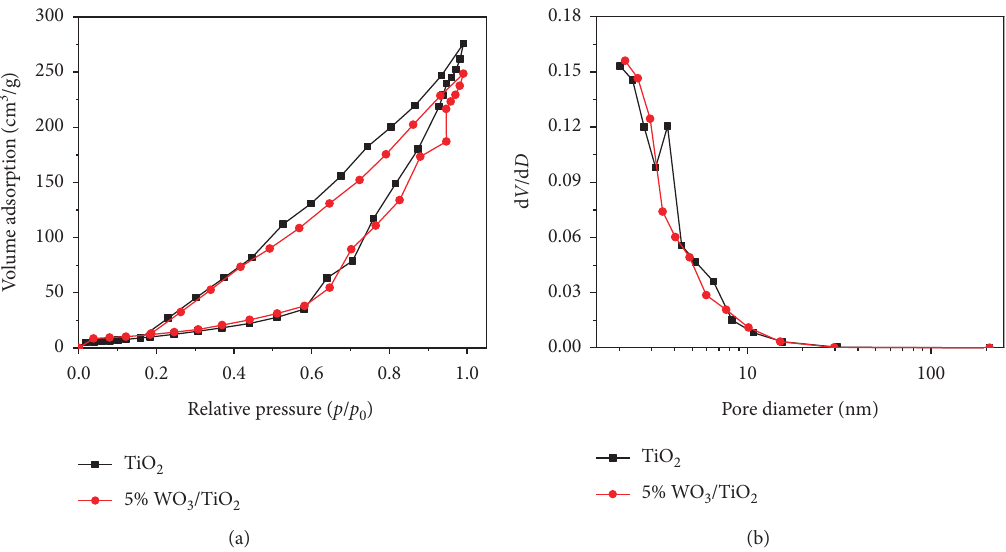
2 and 5% WO 3 /TiO 2 nanofibers.